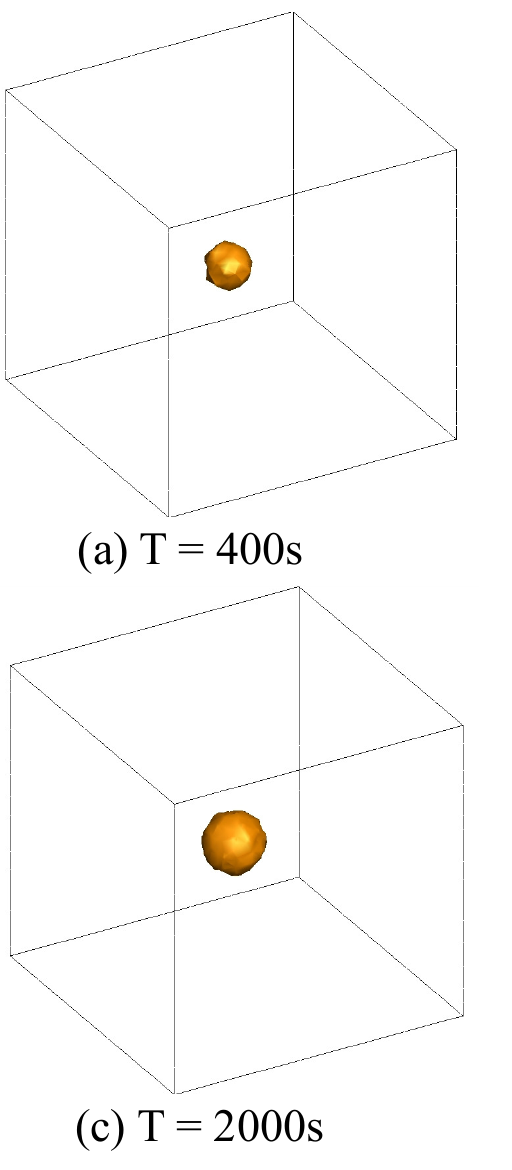
Figure 14. Grout penetration processes at different time steps with a constant injection pressure (P = 50 kPa) in a homogeneous, porous rock considering